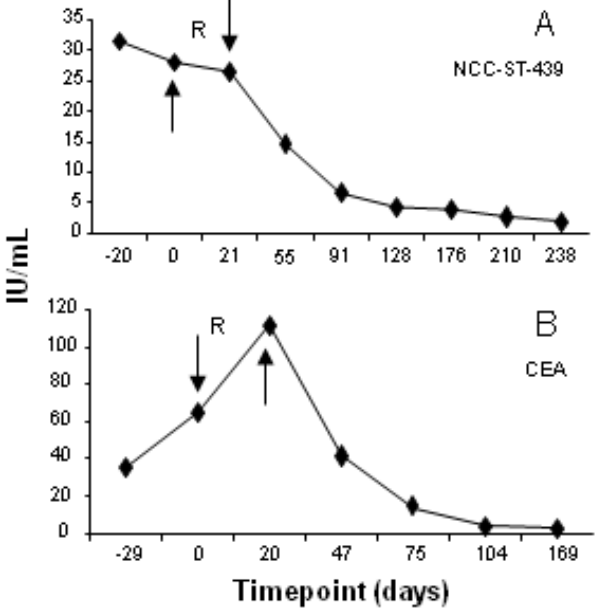
Figure 3. Serum levels of tumor markers relative to treatment sequence. Arrows indicate timepoints of intratumoral injection of iDC and infusion of AT; R denotes the receipt of IMRT. ( A ). Elevated levels of NCC-ST-439 declined to normal after treatment in serum samples obtained from a patient with metastatic breast cancer; ( B ). Elevated serum levels of CEA fell to normal after treatment in a patient with metastatic GI cancer.